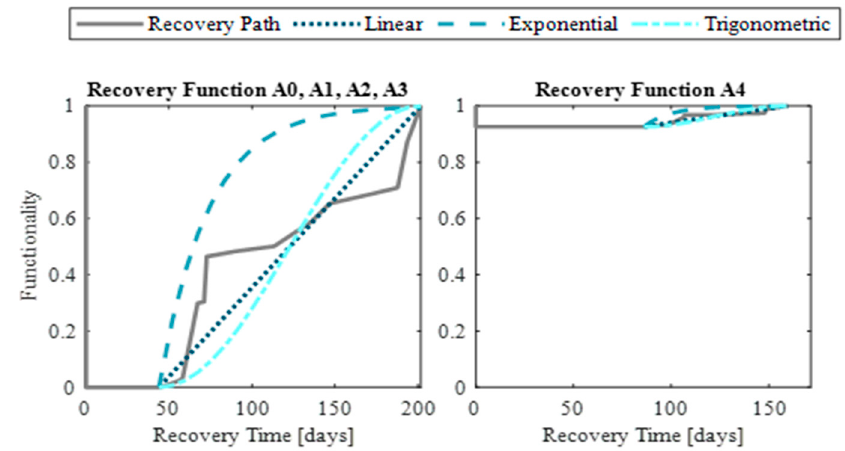
Figure 12. Recovery path for all models at Tr 712 years (SLV).